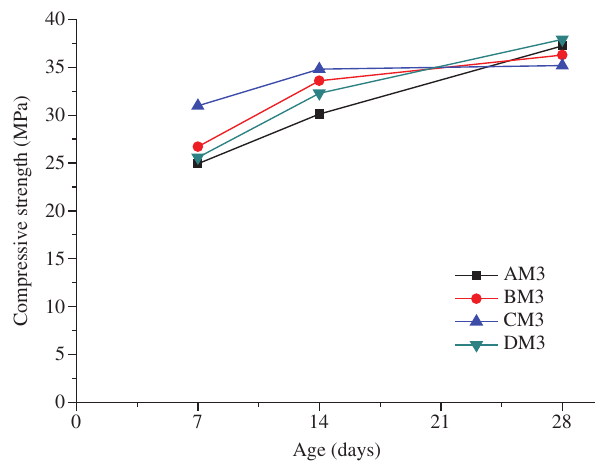
Figure 1: Compressive strength development of AAFA geopolymer with the alkaline solution/binder ratio of 0.35 vs.